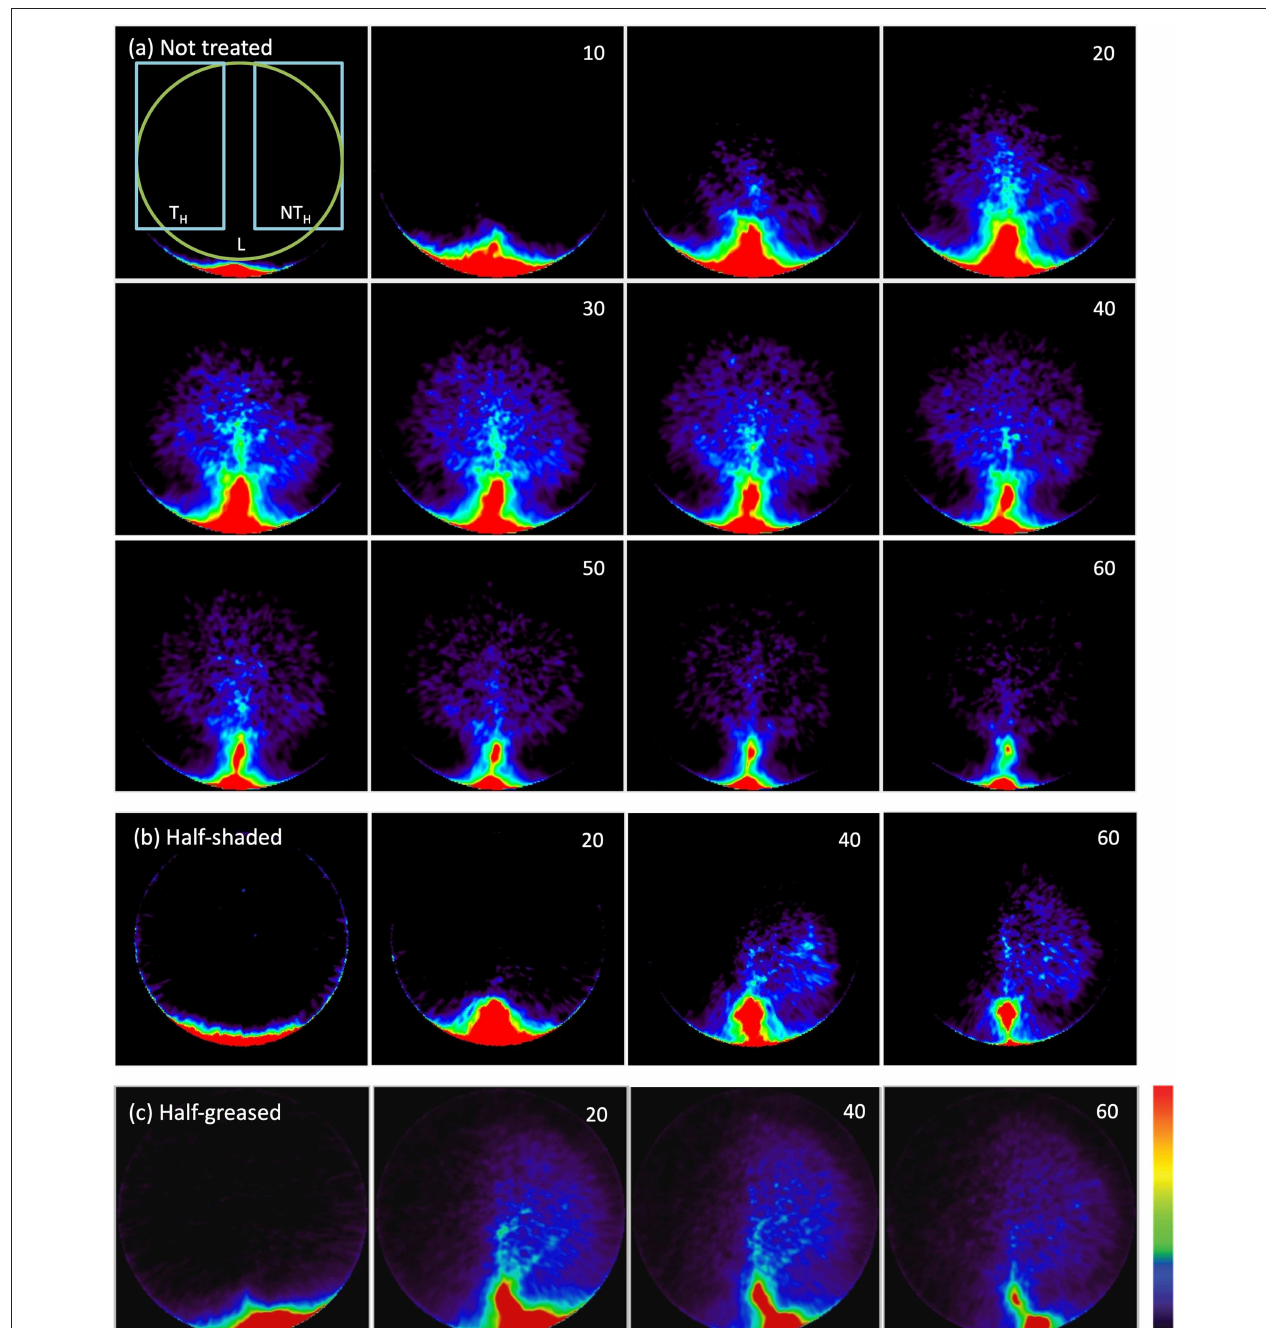
FIGURE 4 | 11 C PET images of a (a) non-treated leaf, (b) half-shaded leaf, (c) half-greased leaf. Numbers in the upper right corner show time (minutes) after the start of labeling. Each image shows the decay-corrected sum of all decay events (tracer) in the last 5-min (a) or 20-min (b,c) interval. The first PET image of (a) displays the ROIs of the leaf (L), treated (T H ) and non-treated (NT H ) halves that were used to create time-series ( Figure 6 ) for all conditions (non-treated, shading and grease). Colors varying from black to red represents no to high tracer as indicated by the color bar.